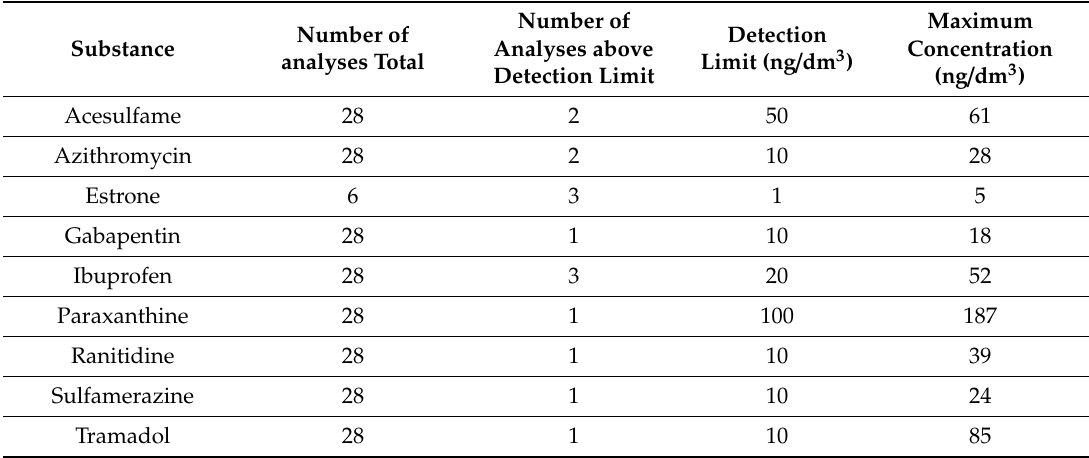
Table 12. Quality of drinking water produced—all substances detected above the detection limit.